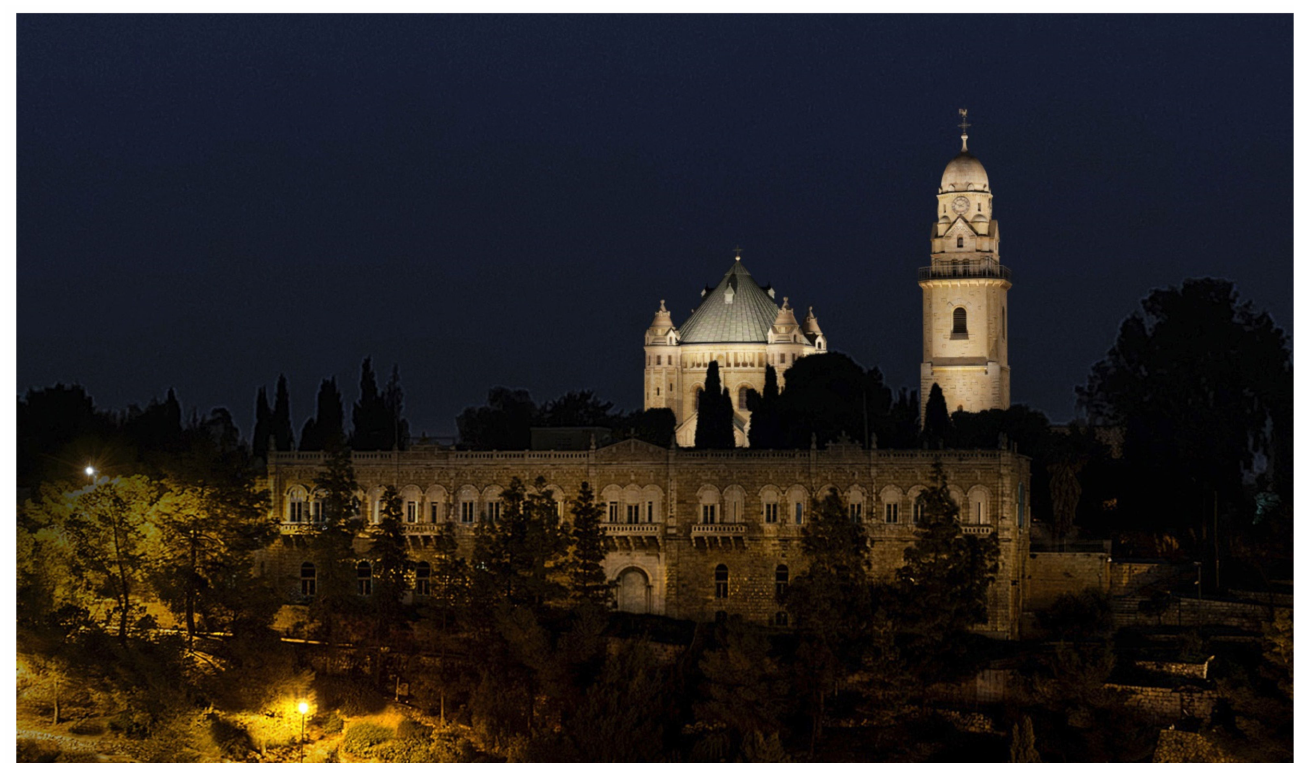
Figure 16. Floodlighting designed for point and direction K2 within the second observation